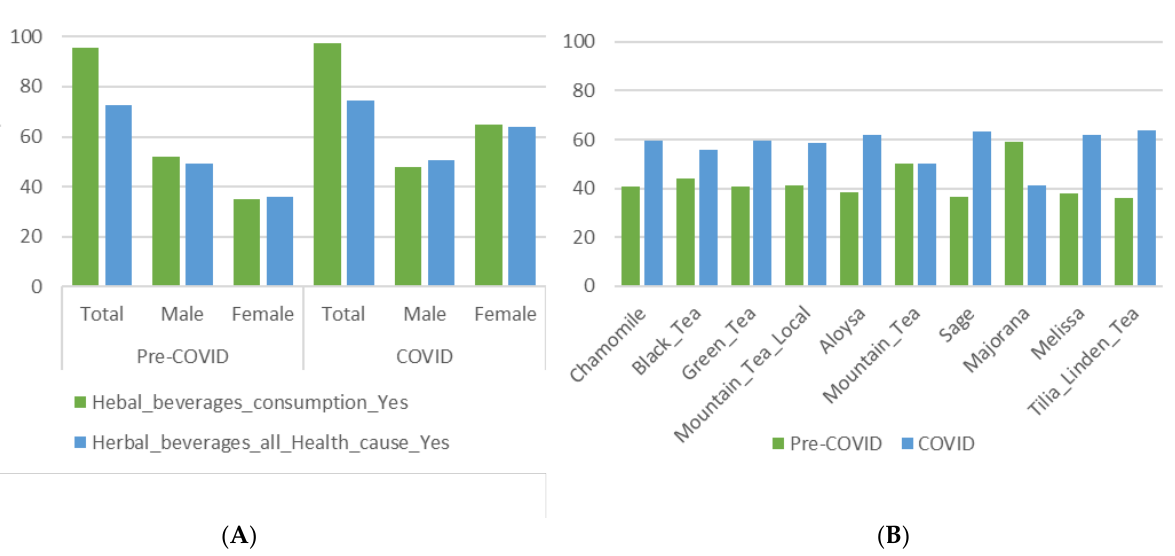
Figure 1. ( A ) % proportional distribution reflecting the cause of use for each MAP, ( B ) ranking of the top 5 MAPs in the conditions.